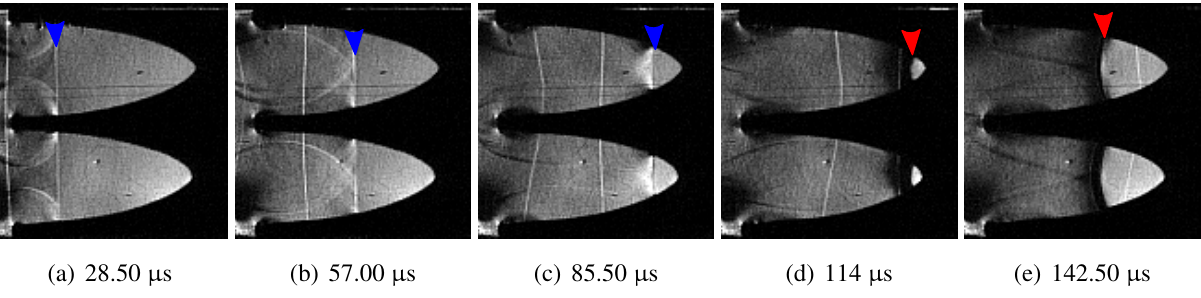
Figure A3. Closed cell foam, Case 2C.